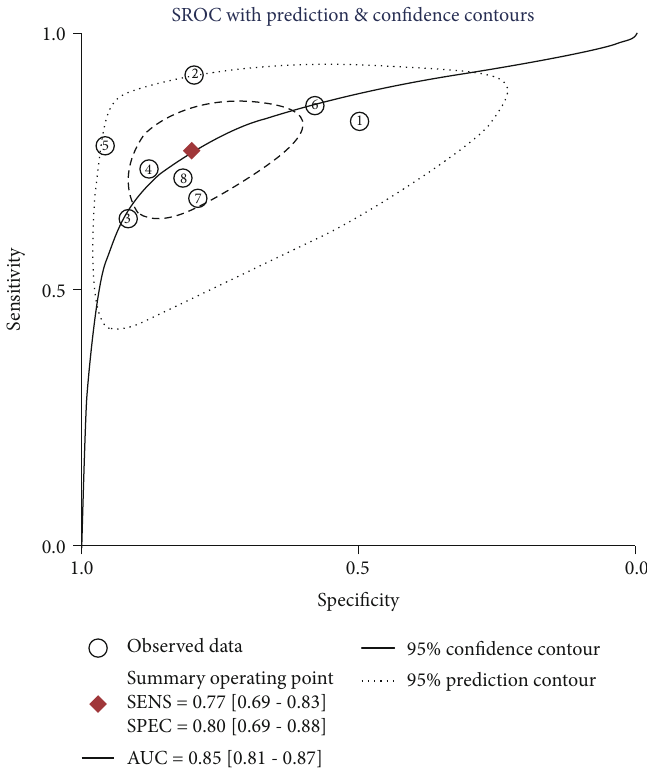
Figure 3: The summary ROC curve (sROC). ROC, receiver operator